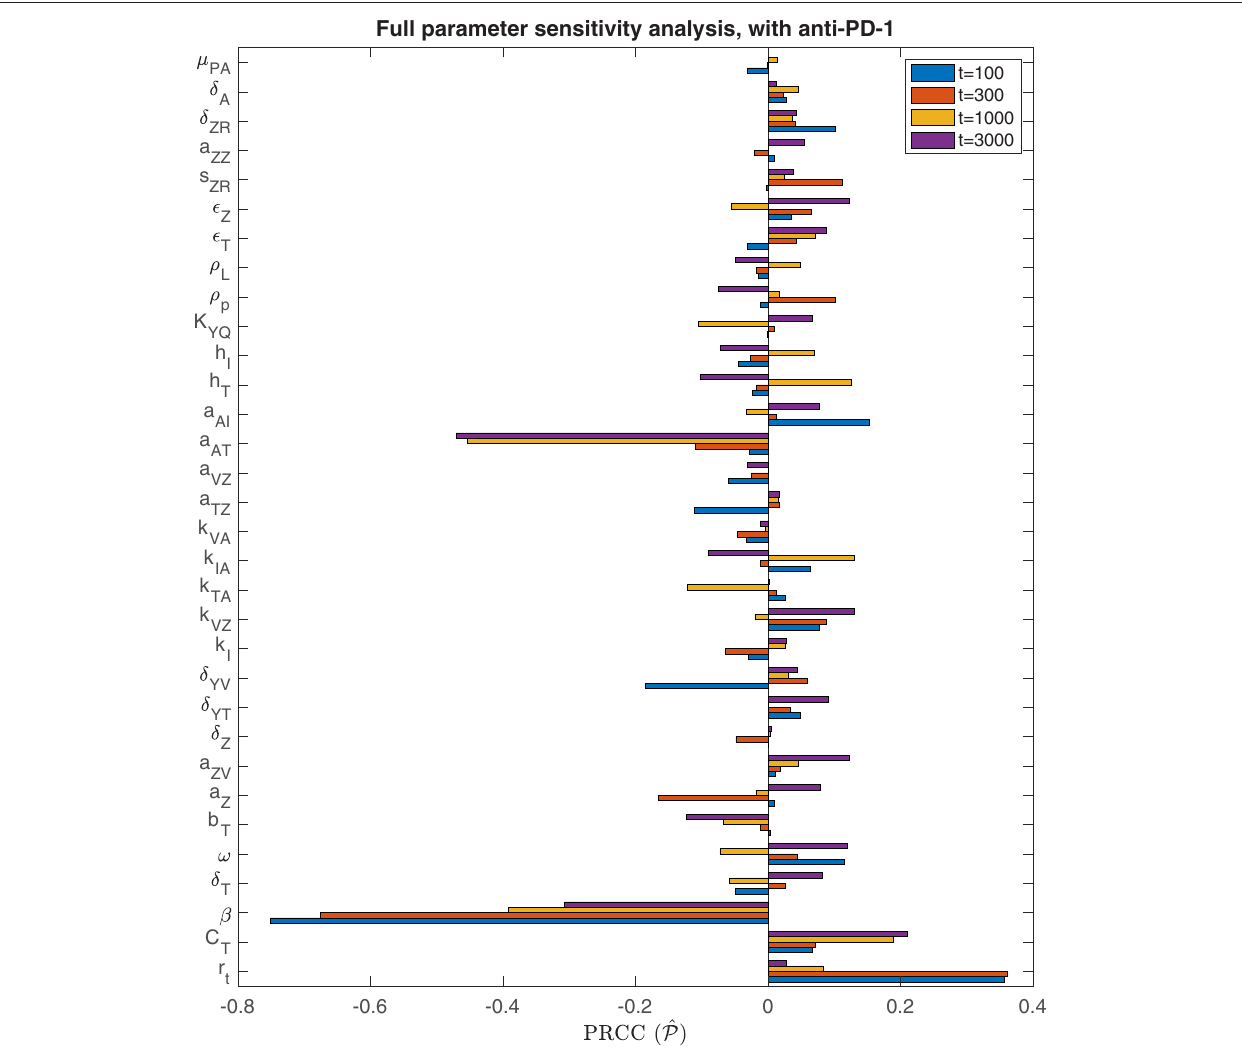
FIGURE 8 | Parameter sensitivity analysis with anti-PD-1. Bar plot of PRCC values for each model parameter, shown for simulation end points at t = 100, t = 300, t = 1,000, and t = 3,000